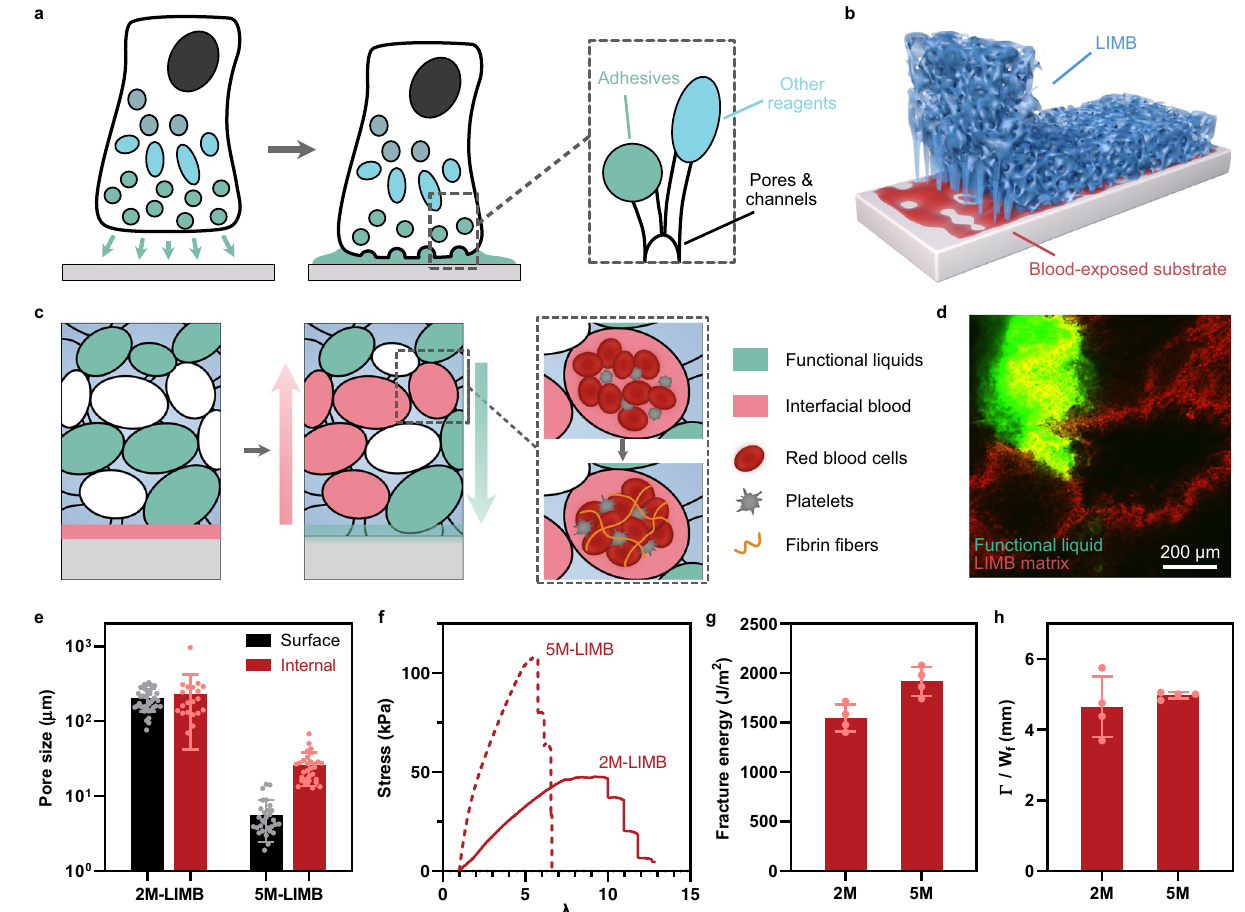
Fig. 1 | Design of LIMB. a Schematic illustration of marine organisms that contain interconnected micropores for adhesiveness and transport of liquid reagents. b SchematicofLIMBadheringonblood-exposedsubstrates. c Schematicsshowing that LIMB can uptake interfacial fl uid, secrete functional liquids, and coagulate blood, thereby providing adhesion, hemostatic, and sealing function. d Confocal image of rhodamine-labeledLIMB(red)containing micropores, partially fi lledwith